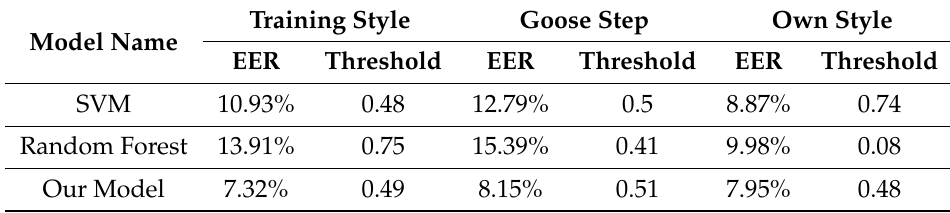
Table 1. Results of our